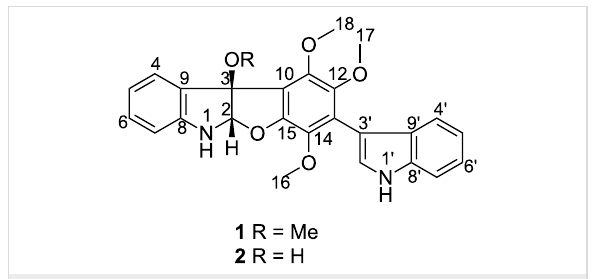
Figure 1: Structures of the isolated compounds 1 and 2 .